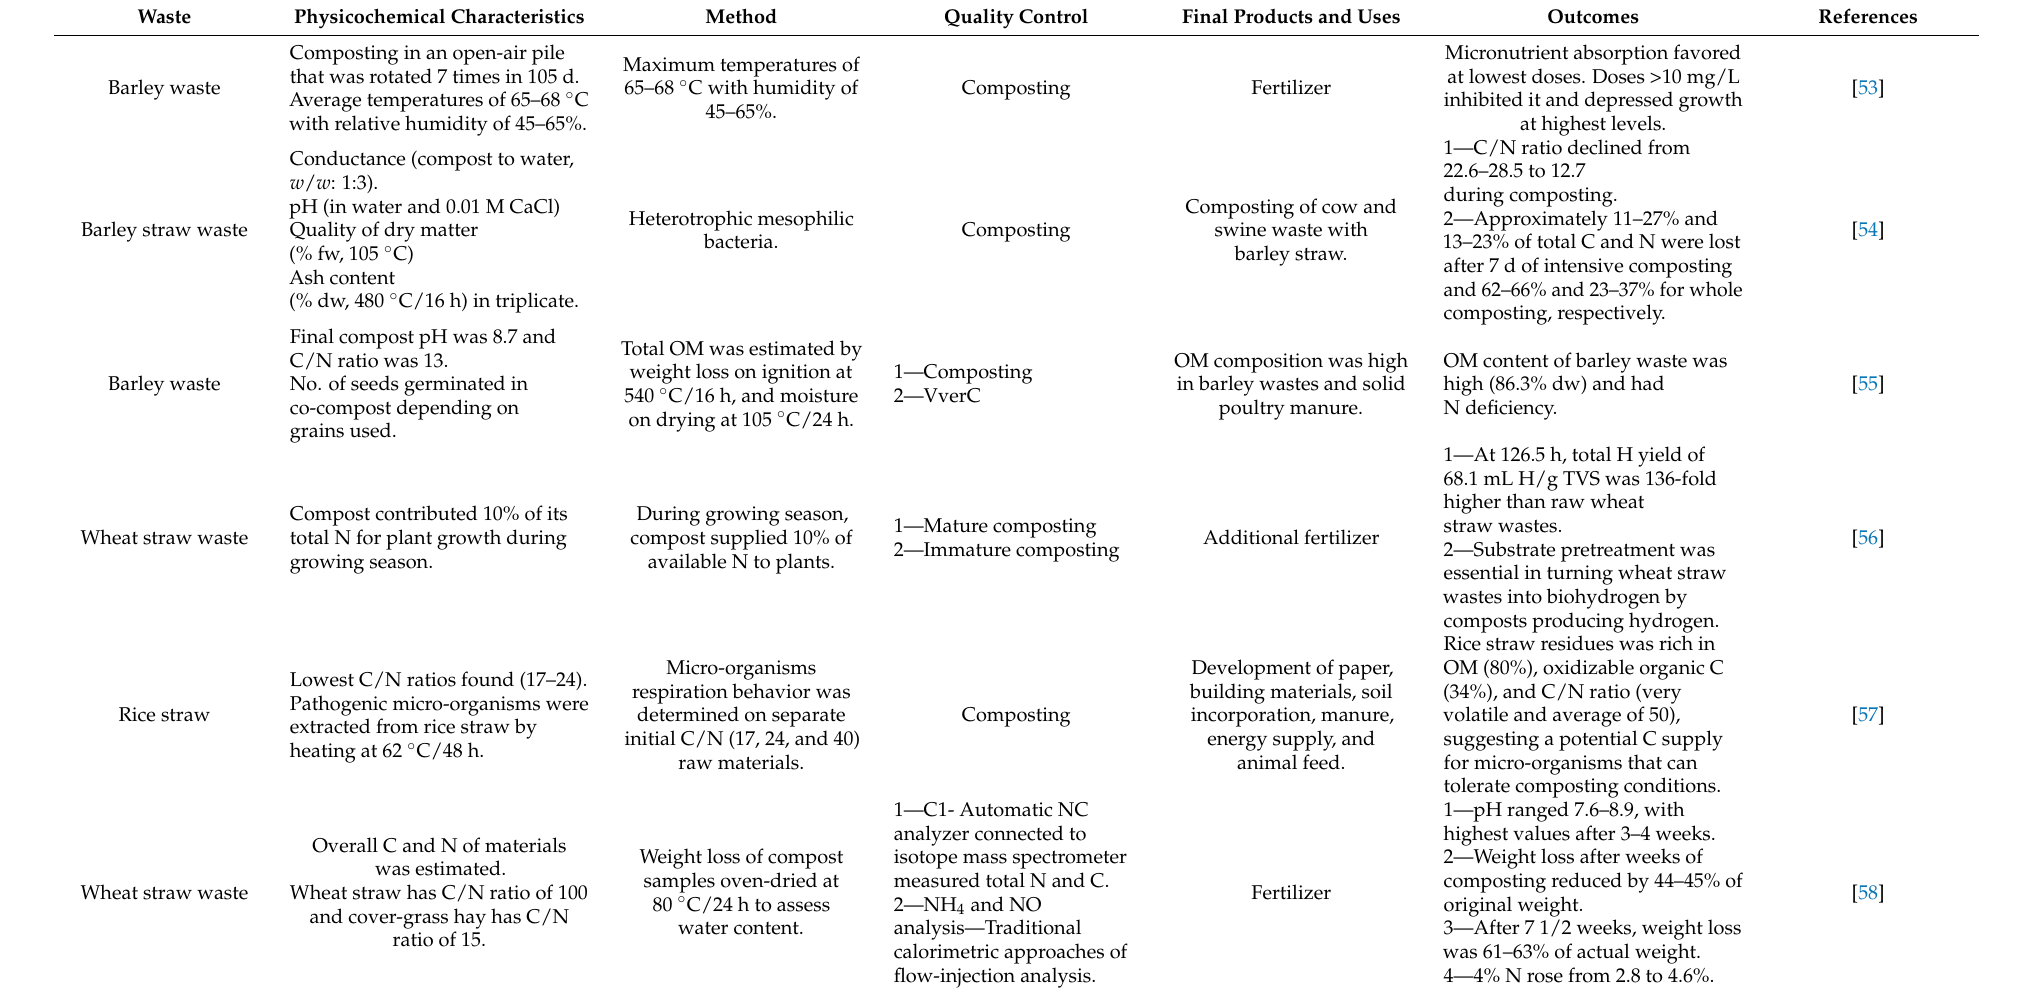
Table 1. Treatment methodologies of different types of crop